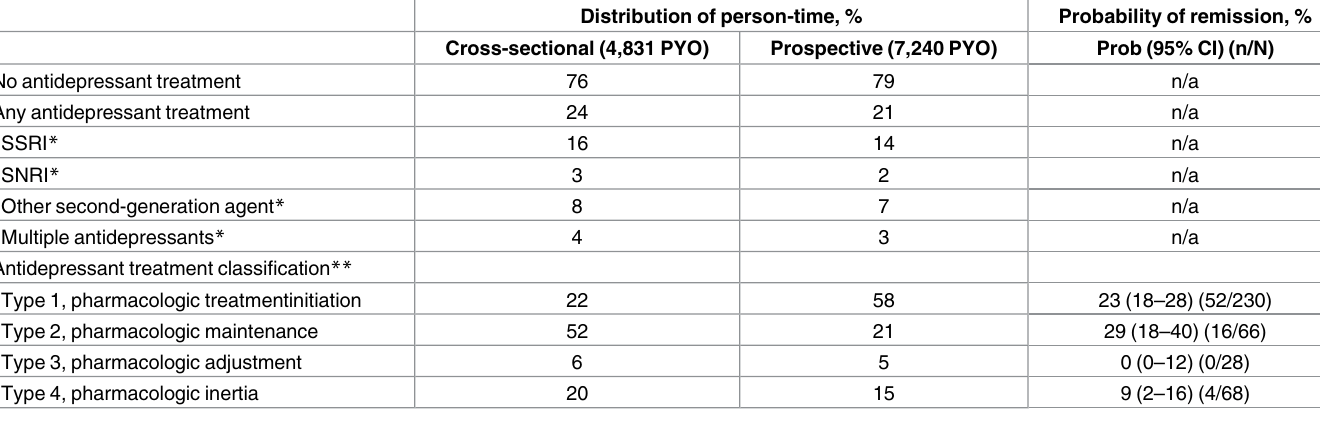
Table 2. Antidepressant treatment, treatment adjustments, and remission.